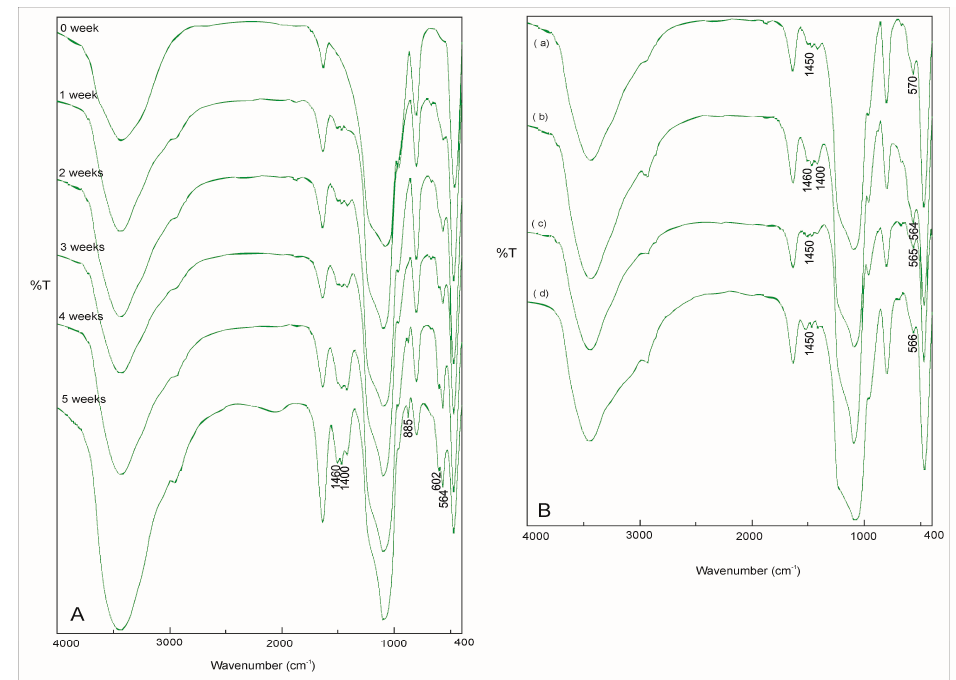
Figure 4. FTIR spectra of ( A ) MCM-41 during the 5 weeks of mineralization studies in simulated body fluid and ( B ) (a) MCM-41, (b) MCM-epoxy, (c) MCM-SH, and (d) MCM-NH 2 after 2 weeks of mineralization studies in simulated body fluid.